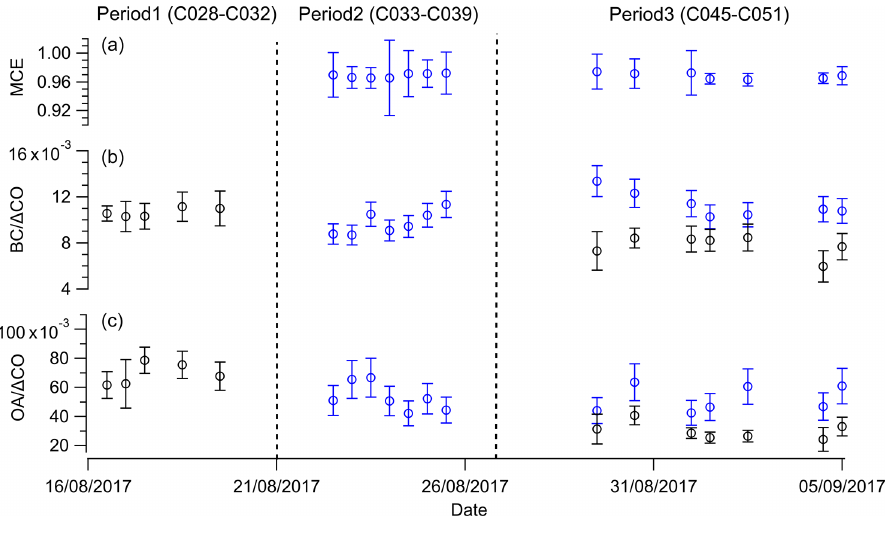
lantic. BC /(cid:49) CO and OA /(cid:49) CO ratios in the BL were